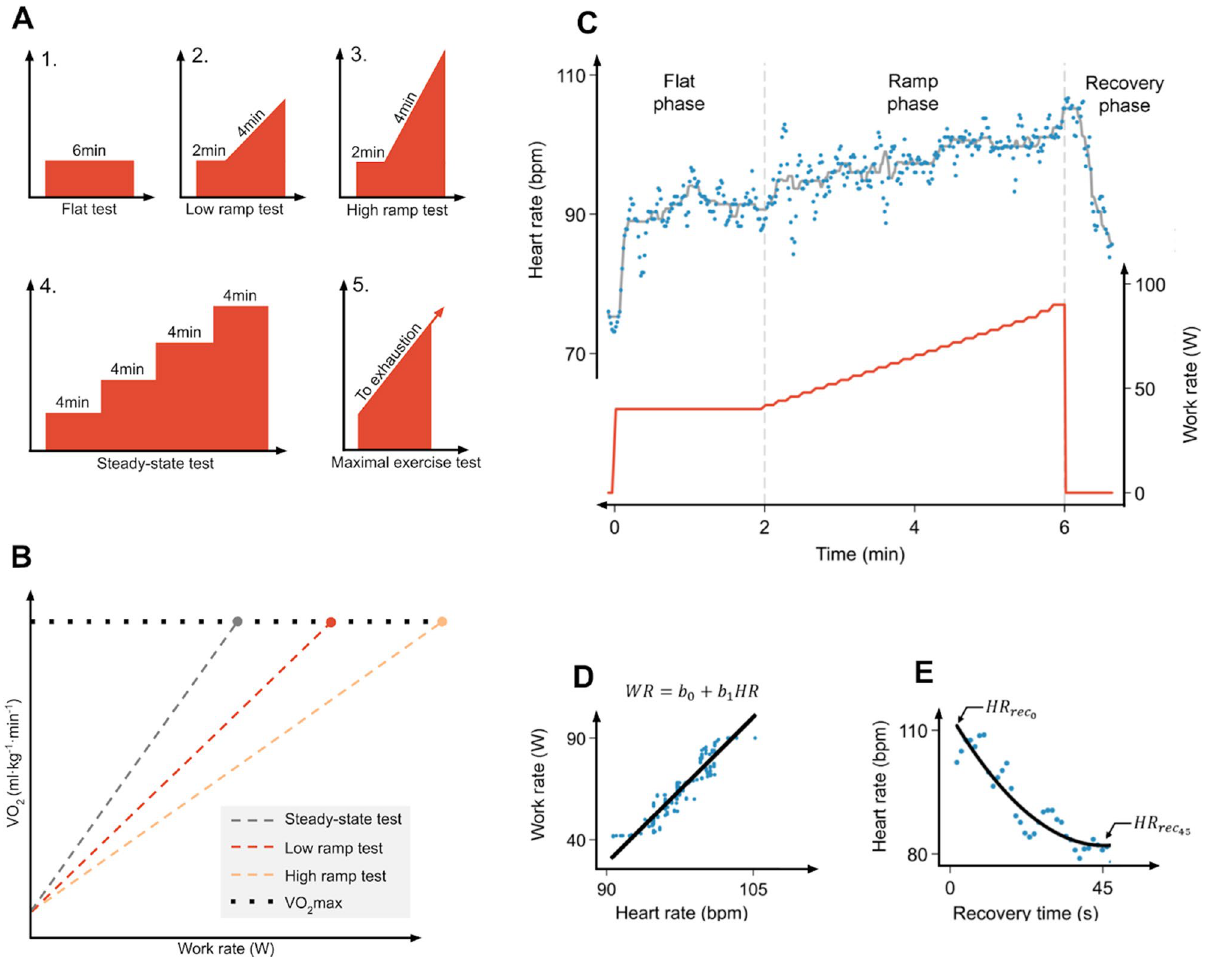
Figure 1. Conceptual framework and design for validation study. ( A ) Overview of the five exercise tests performed by validation study participants (3 UKB-CRF tests (flat protocol, low ramp protocol, high ramp protocol), 1 steady-state test unique to the validation study, and 1 maximal exercise test to measure VO 2 max). X-axes: Time; Y-axes: Work rate (WR). Tests were completed consecutively, and work rates were individualised according to standardised criteria (See `Experimental procedure and equipment’ in Methods). UKB-CRF test and steady-state test data were used for method development. Maximal exercise test data were withheld from method development and used for validation purposes only. ( B ) Conceptual plot of WR-to-VO 2 response during steady-state and ramped exercise tests. VO 2 increases linearly at a rate proportional to the rate of change in WR (i.e. ramp rate) until VO 2 max is reached (in an exhaustive test). The WR-to- VO 2 relationship (line slope) changes depending on the ramp rate of the test. As ramp rate decreases, the WR when VO 2 max is achieved approaches the maximal WR for an exhaustive steady-state test. Note that VO 2 is extrapolated to maximal values for demonstrative purposes, but in the validation study ramped and steady-states tests were non-exhaustive. ( C ) Exemplar HR data (blue scatter and grey line; upper panel), WR data (red line; lower panel), and test phase annotation for ramp test. ( D , E ) Feature extraction for ramp phase using simple linear regression model and for recovery phase using first-order exponential decay model (see Supplemental tests and 7.5–25 W min −1 for ramp tests), finding mean bias to be minimal across all ramp rates tested (Fig. 3, lower panel). For method-comparison purposes, we also assessed the absolute and internal validity of a simple linear regression CRF estimation method used previously by our group and a two-point CRF estimation method used by other groups working with UKB data. These latter two methods relate exercise HR response to WR without accounting for protocol ramp rate. Both methods demonstrated overestimation bias and low precision when applied to ramped tests but had low bias when applied to flat tests (Supplemental Fig. 2). To assess measurement consistency of the UKB-CRF test, we evaluated short-term test–retest reliability in validation study participants and long-term test–retest reliability in UKB participants (Fig. 4). In validation study participants with short-term repeat tests (within 2 weeks, n = 87), estimated VO 2 max values from the first and second UKB-CRF tests were highly correlated (r = 0.91) with no mean difference. Agreement was nearly as strong (λ = 0.79) in UKB participants with long-term repeat tests (about 2.8 years between tests, n = 2877).